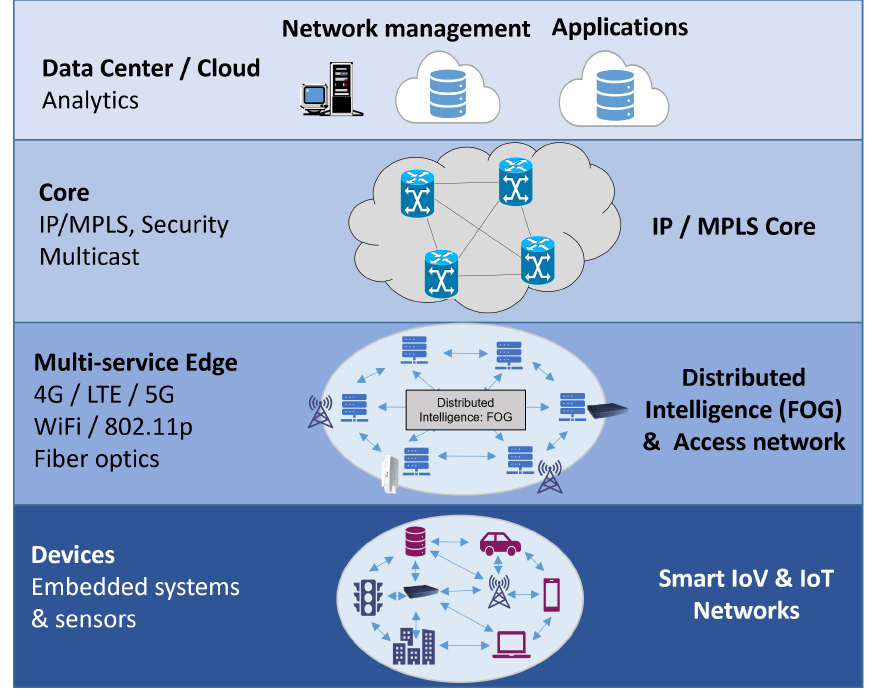
Figure 1. Fog Computing conceptualized architecture. Table 1. Comparison between VCC, VEC, and VFC